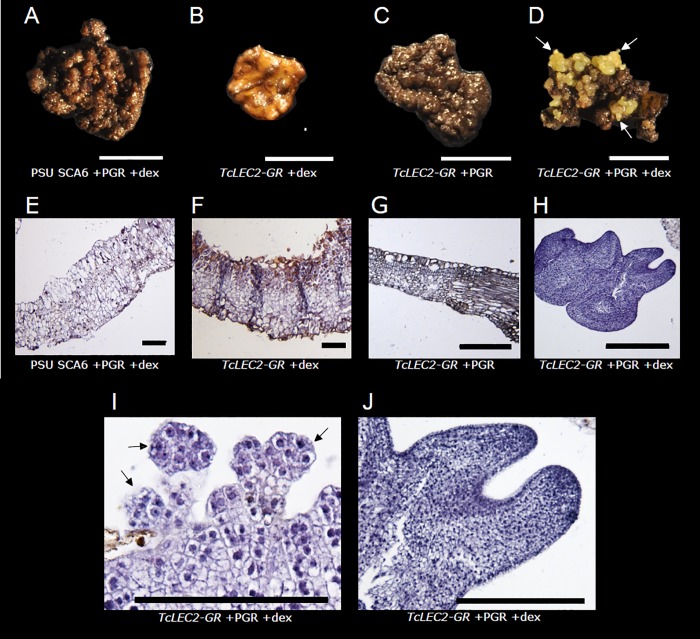
Representative images of somatic embryos regeneration from cacao leaves.A-D. Photographs of leaf explants from PSU SCA6 or transgenic TcLEC2-GR leaves +/- dex and plant growth regulators (PGR). Arrows in D indicate immature embryos. Scale bars = 1 cm. E-J. Representative images of histological analysis of leaf explant cross sections from the same treatments as A-D. Scale bars = 0.1 mm. Arrows in (I) indicate nascent globular embryos.